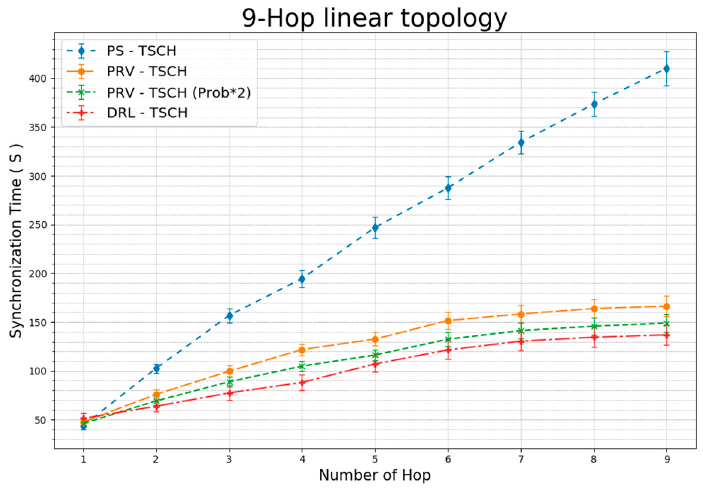
Figure 13. Average Synchronization Time for Each Hop Using 9-Hop Linear Topology (standard error).